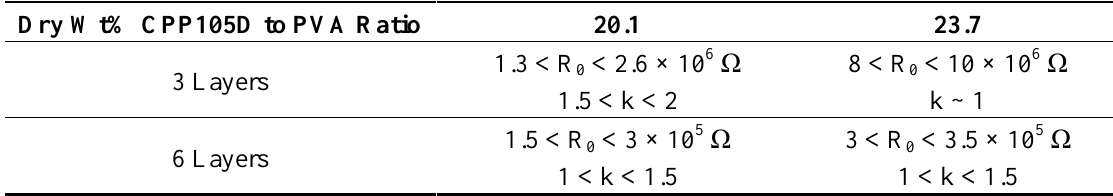
Table 3. Comparison of the second series of